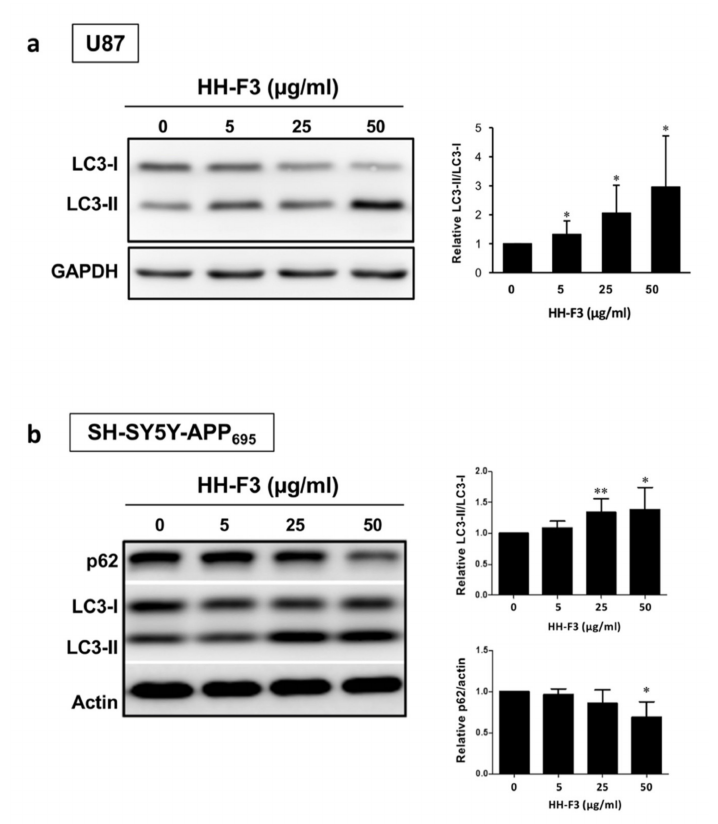
Figure 4. GP extract HH-F3 activated autophagy in U87 and SH-SY5Y-APP 695 cells. ( a ) The expression of LC3-I and LC3-II in U87 cells treated with 0, 5, 25, and 50 µ g/mL for 24 h. The bands were